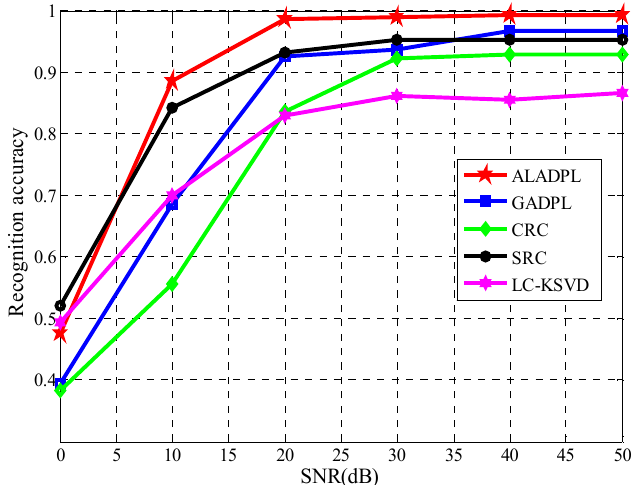
Figure 18. Performance of the algorithm with varying SNRs.